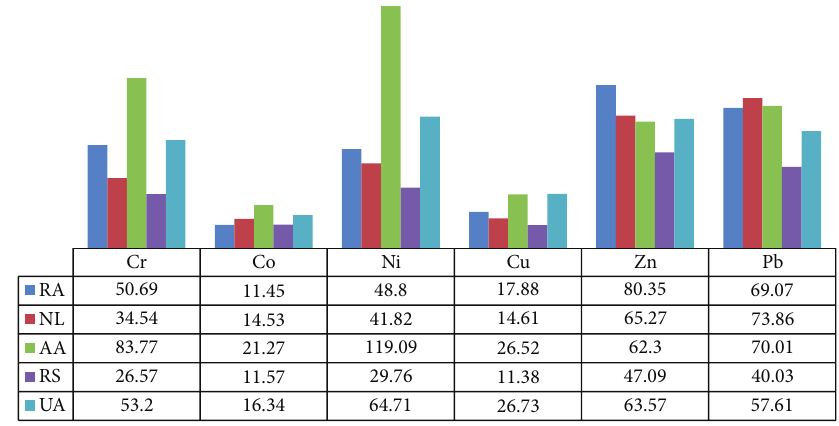
Figure 2: Heavy metal mean values of soil samples according to the land-use class